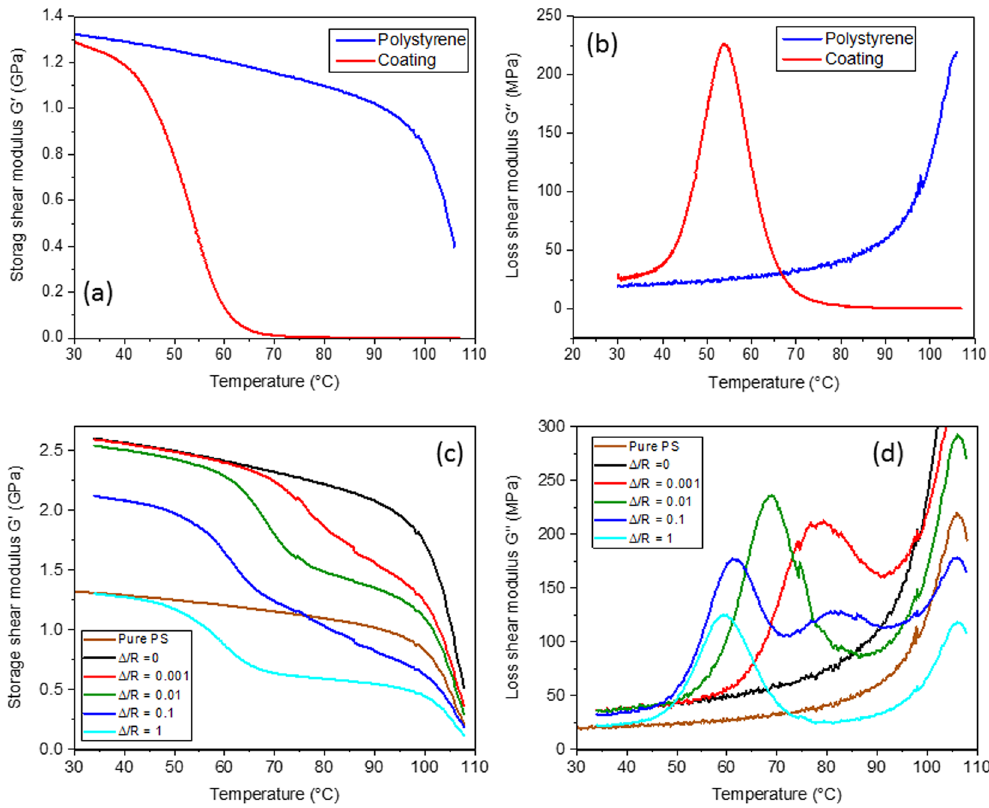
Figure 1. Motivation for the current experimental study. ( a ) and ( b ) The storage and loss moduli for the composite constituents, namely the viscoelastic polyurethane coating and the solid polystyrene matrix. ( c ) Analytical predictions for the storage shear modulus G ′ of a random dispersion of coated glass spheres of radius R with different coating thickness, Δ , at a volume fraction of spheres of c = 0.3. ( d ) A similar prediction but for the loss shear modulus G ′′